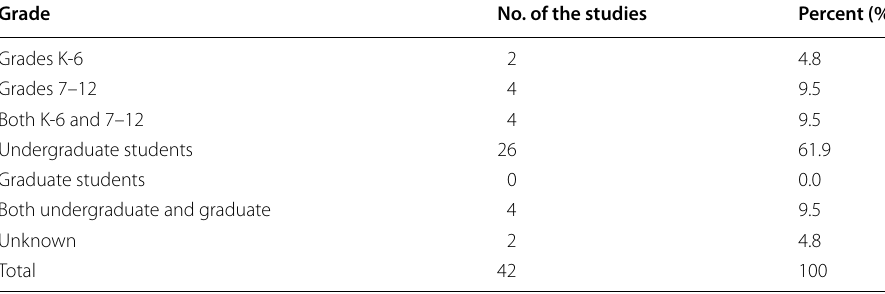
Table 3 The Level of students studied Grade